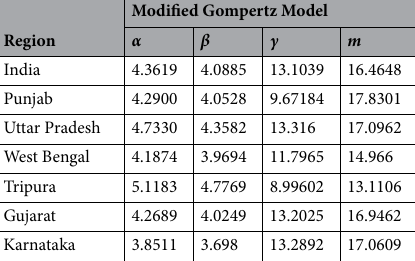
Table 7. Estimates of parameters of Modified Gompertz Model for India and 6 selected states.